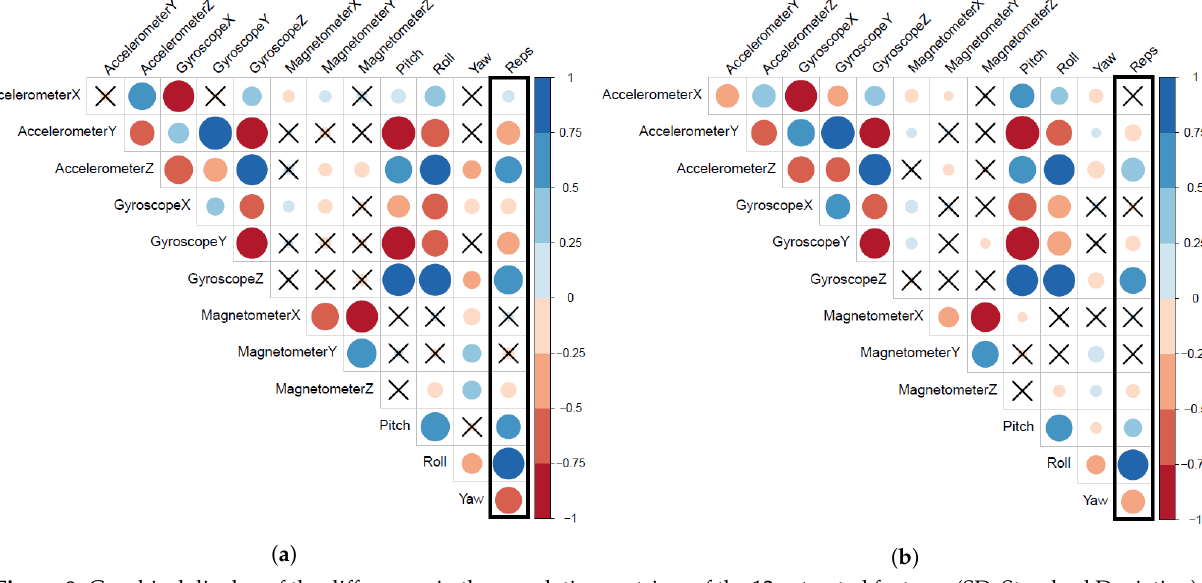
Figure 9. Graphical display of the differences in the correlation matrices of the 12 extracted features (SD: Standard Deviation) and the bicep repetitions with and without fatigue. ( a ) Correlation matrix of the 12 SD features and bicep repetitions in the non-fatigue subset. ( b ) Correlation matrix of the 12 SD features and the bicep repetitions in our complete